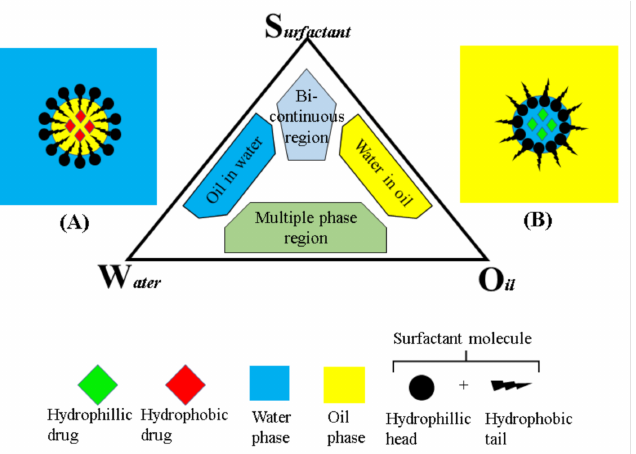
Figure 2. The phase diagram illustrates the components of nanoemulsions; oil, surfactant, and water. The schematic diagrams ( A , B ) represent oil-in-water and water-in-oil nanoemulsions, with the surfactant molecule positioned oppositely in each case. This figure is